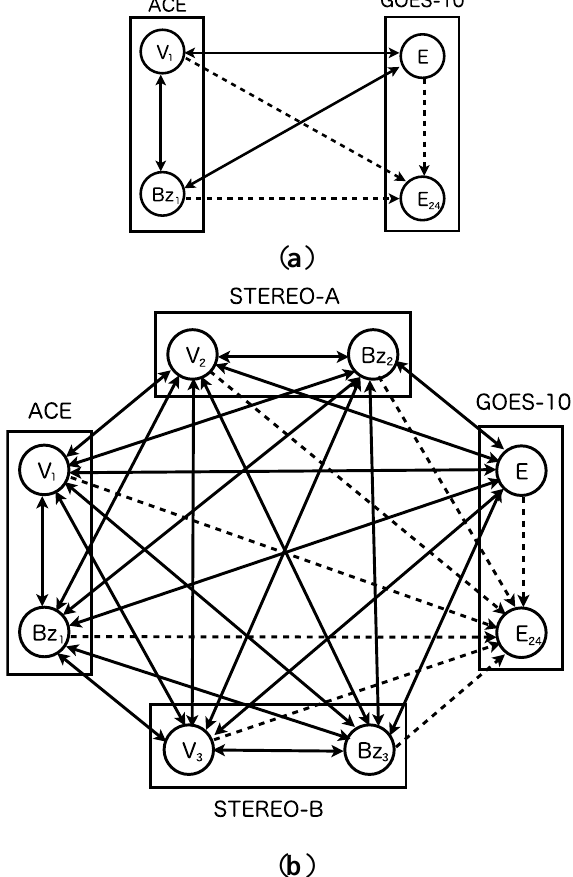
Figure 1. Dynamic relational network for space weather forecast using multiple sensors. ( a ) Four-sensor model ( b ) Eight-sensor model. V and B ( i = 1, 2, 3) represent sensor nodes i i of solar wind speed and north-south component of interplanetary magnetic field. E and E 24 indicate, respectively, a present high-energy electron flux and its flux 24 h ahead. Rectangles represent regions of satellites equipped with sensors for observation. Solid line arcs represent evaluations from a source node to a target node. Dashed line arcs indicate evaluations involving a prediction from a source node to a target